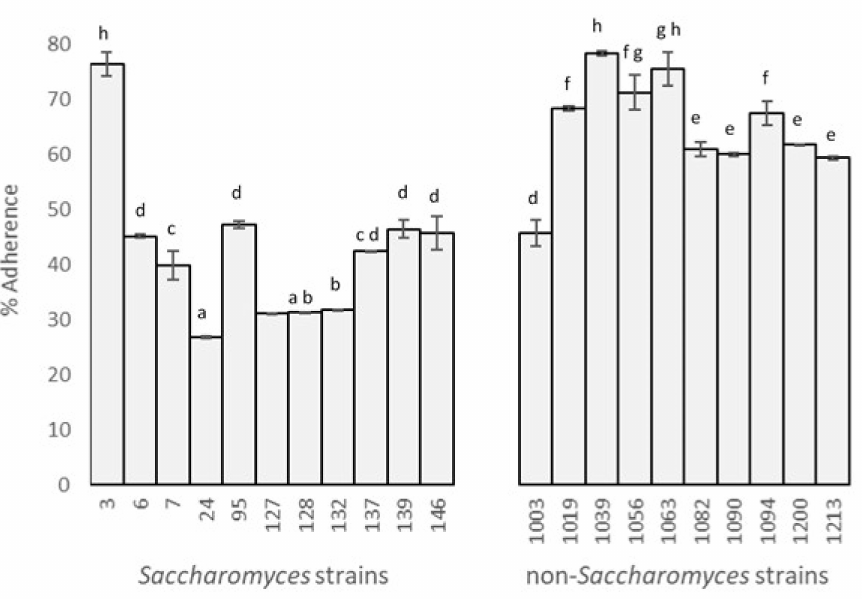
Figure 1. Percentages of yeast adhesion to Caco-2/TC7 cells (different letters indicate significant differences between